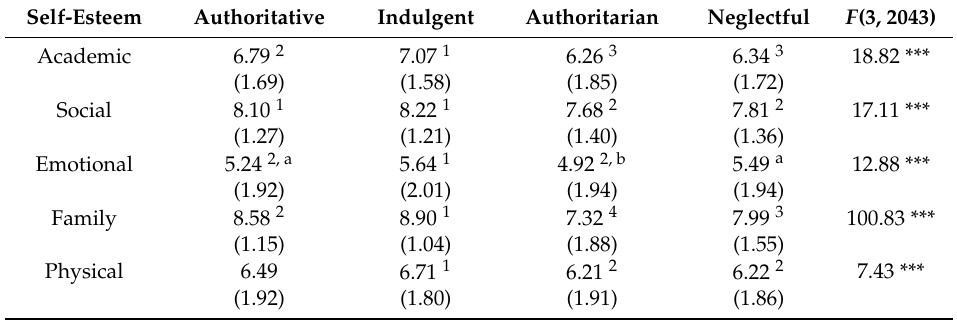
Table4. Meansand(standarddeviations)ofparentingstyle, andmainunivariate F valuesforself-esteem.